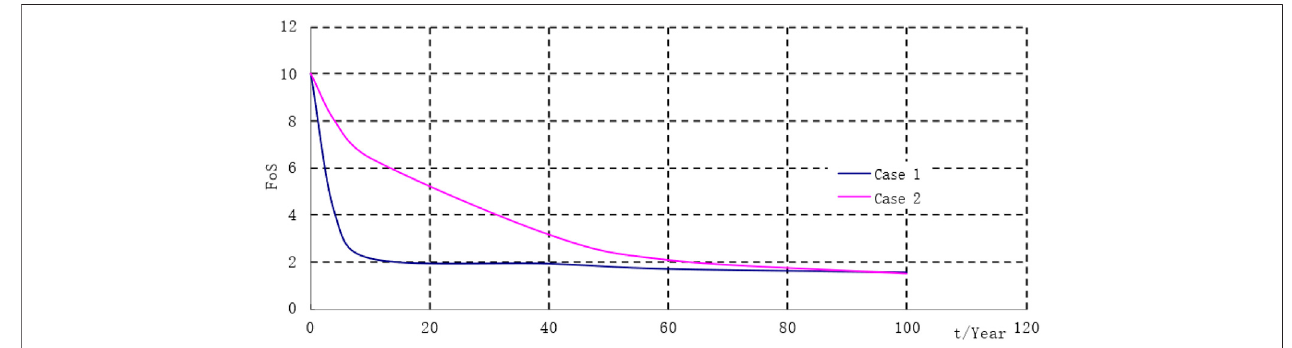
FIGURE 9 | FoS evolution (in vault roof) with